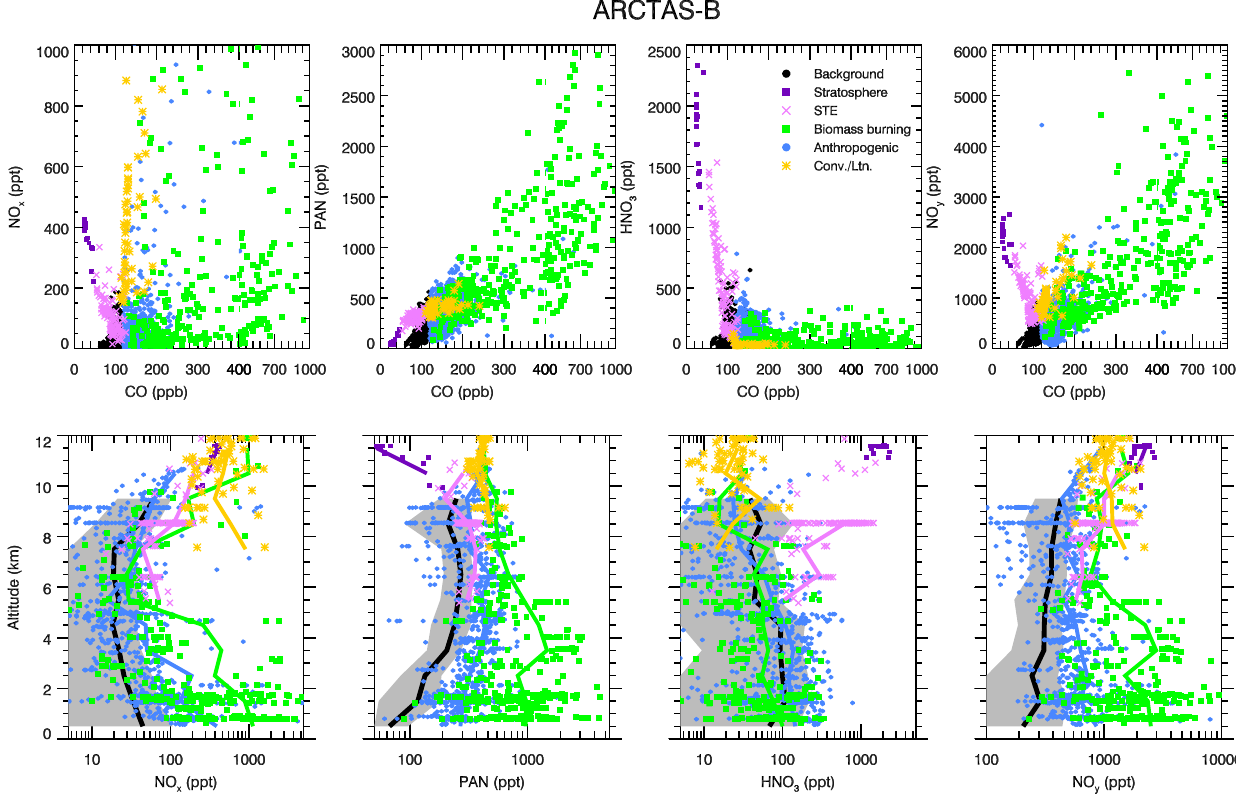
Fig. 5. Same as Fig. 4 but for ARCTAS-B. Note part of the x-axis in the top panels for CO between 400–1000ppbv is condensed in length for better visualization of the air mass